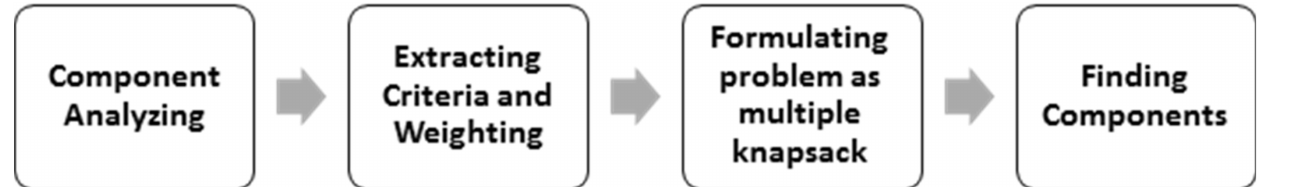
Figure 2. Phases of the proposed framework. Table 1. Symbols of the